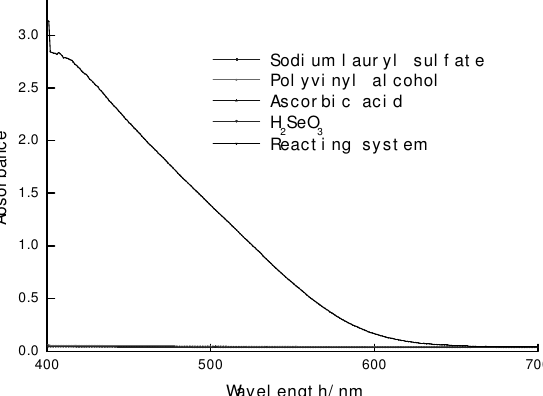
Figure 1. Absorption spectra of Vc solution;H